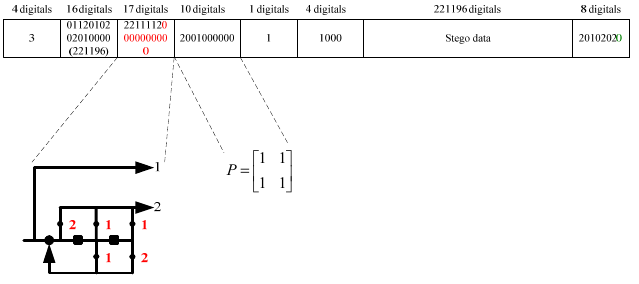
Figure 12. Example of the packet form.